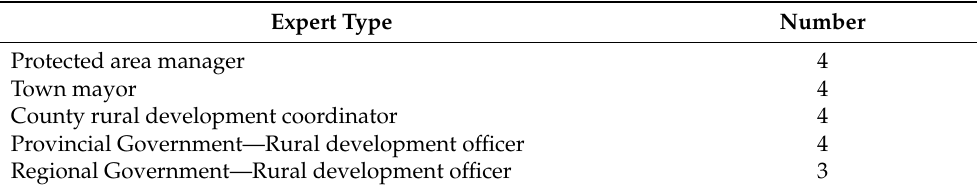
Table 2. Type of expert interviewed by phone on the protected